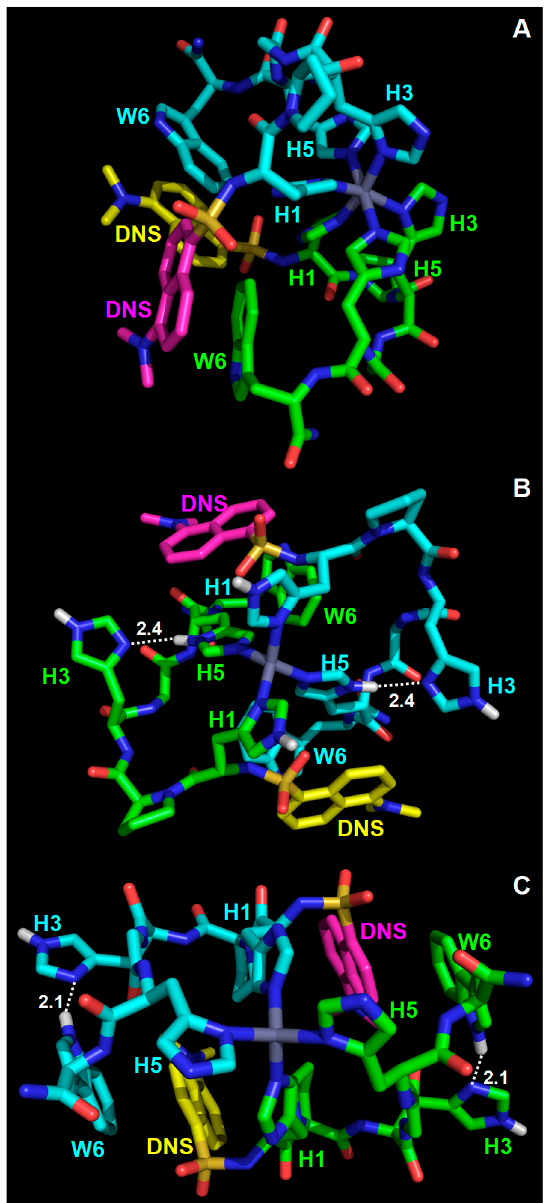
Figure 4. Representative Monte Carlo minimized models of the Zn(dH3w) 2 complex. ( A ) The most stable octahedral complex model. His1, His3, and His5 are coordinated through the N ε , N δ , and N ε nitrogen atoms, respectively. ( B ) Tetrahedral complex model in which His1 and His5 are coordinated through the N δ and N ε nitrogen atoms, respectively, whereas His3 is protonated at the N ε nitrogen atom and, with its N δ nitrogen atom, is H-bonded to the H-N δ group of His5. ( C ) Tetrahedral complex model in which His1 and His5 are coordinated through the N ε and N δ nitrogen atoms, respectively, whereas His3 is protonated at the N ε nitrogen atom and, with its N δ nitrogen atom, is H-bonded to the H–N group of the indole moiety of Trp6. Residues are shown as sticks colored by atom type: nitrogen, blue; oxygen, red; sulphur, dark yellow. Carbon atoms of the two peptide molecules are green and cyan, except for the carbon atoms of the dansyl groups (DNS) that are yellow and magenta, respectively. Zn(II) is gray. Hydrogen atoms are shown only when relevant and are white. Hydrogen bonds are shown as white dotted lines and the corresponding distances are in Å.